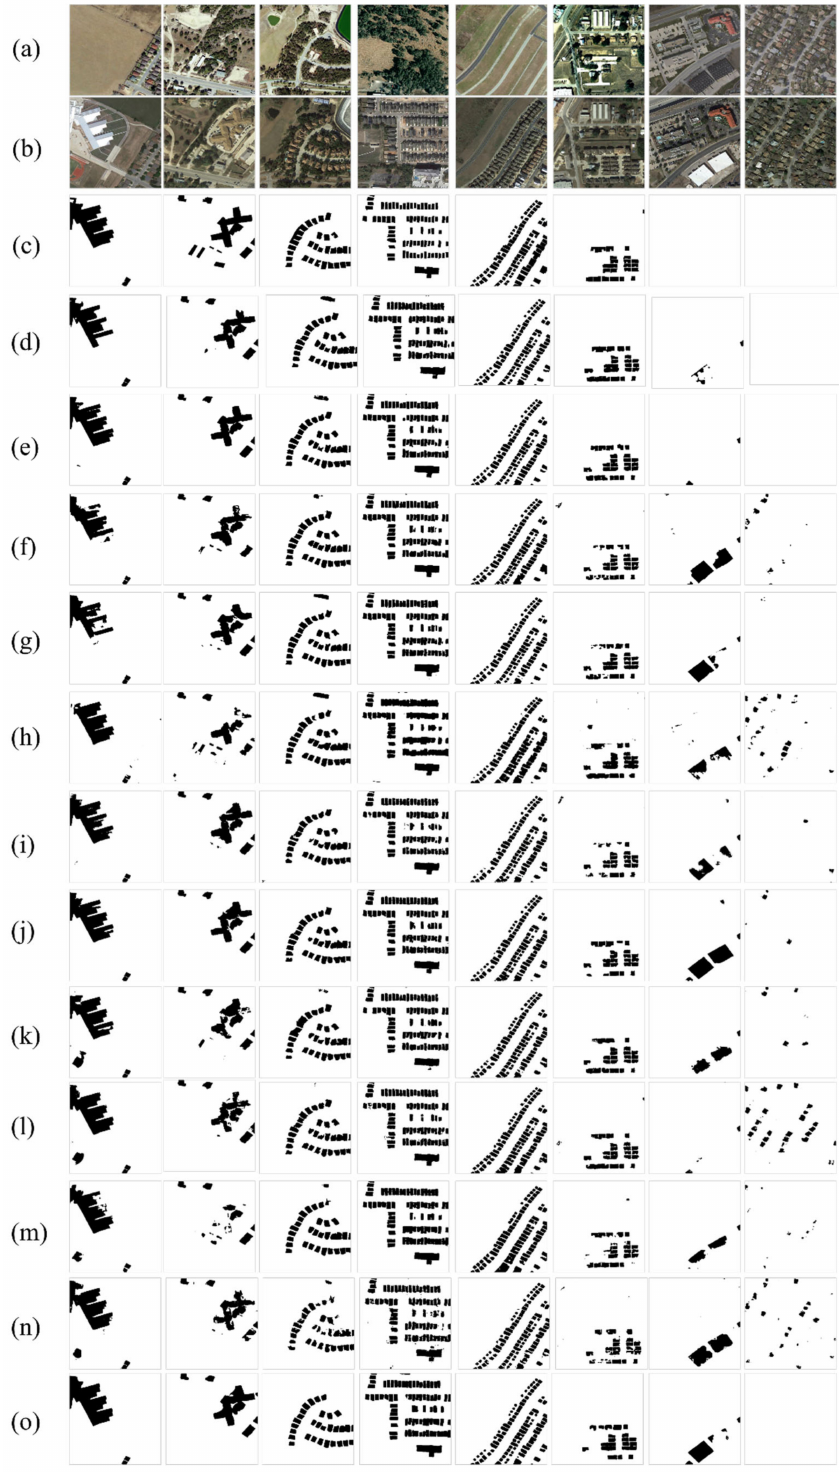
Figure 4. CD results of 3M-CDNet and other benchmarks on the LEVIR-CD dataset. Zoom in for an improved view. ( a ) Image T1. ( b ) Image T2. ( c ) Reference change map. ( d ) 1M-CDNet. ( e )